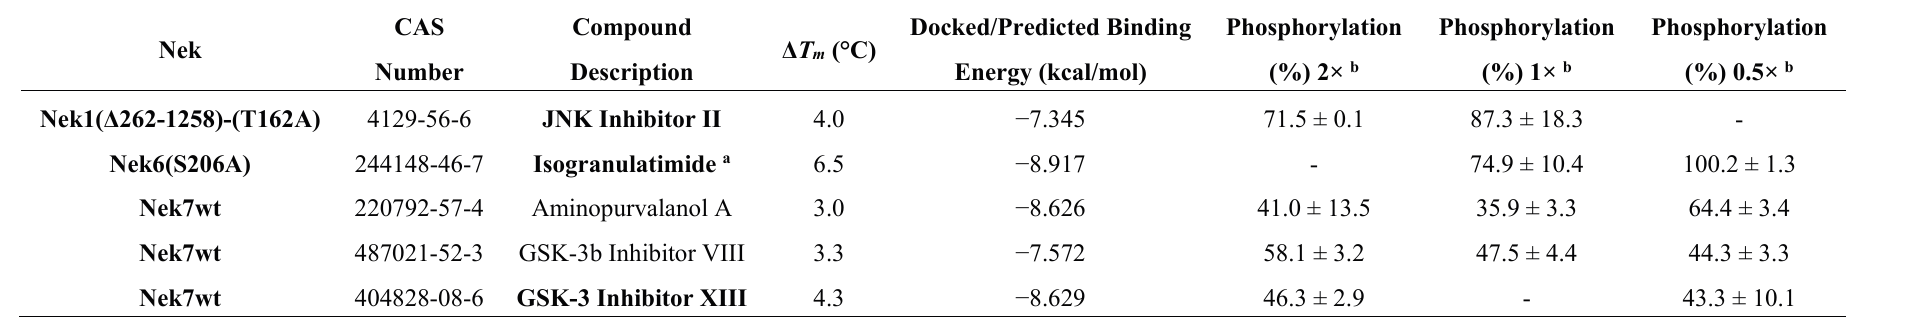
Table 3. Summary of compounds with thermal shifts of at least 3 °C ( Δ T m ≥ 3 °C), total predicted ligand-protein binding energies in ATP-binding site and percent phosphorylation activity up to 75% for recombinant hNeks 1, 6, and 7. The percent phosphorylation is according to a compound final concentration of 2×, 1×, and 0.5× the ATP K m[apparent] concentration of each kinase. The ATP K m[apparent] concentrations found for Neks are as follows: 0.625 µM for hNek6(S206A) and hNek7wt, and 25 µM for hNek1( Δ 262-1258)-(T162A). Only percentage of phosphorylation values with standard errors < 20 are depicted in the table. Names of compounds corresponding to Δ T m ≥ 4.0 °C and phosphorylation ≤ 75% are depicted in bold and were selected as the best candidates for hNeks.